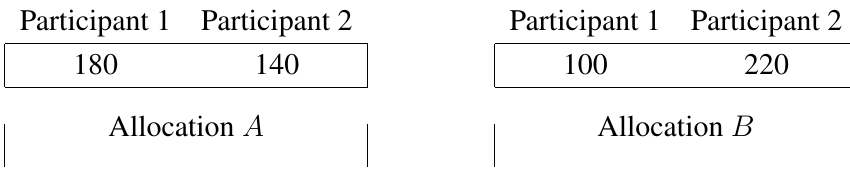
Figure 1. ECU allocations (to be decided by participant